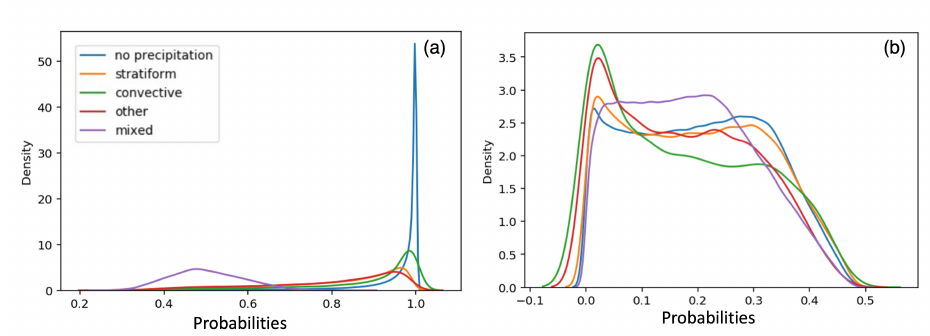
Figure 5. Distribution of probabilities for each precipitation type class produced by CNN model for ( a ) correct predictions and ( b ) incorrect predictions. Density corresponds to the absolute occurrence rate among all situations.